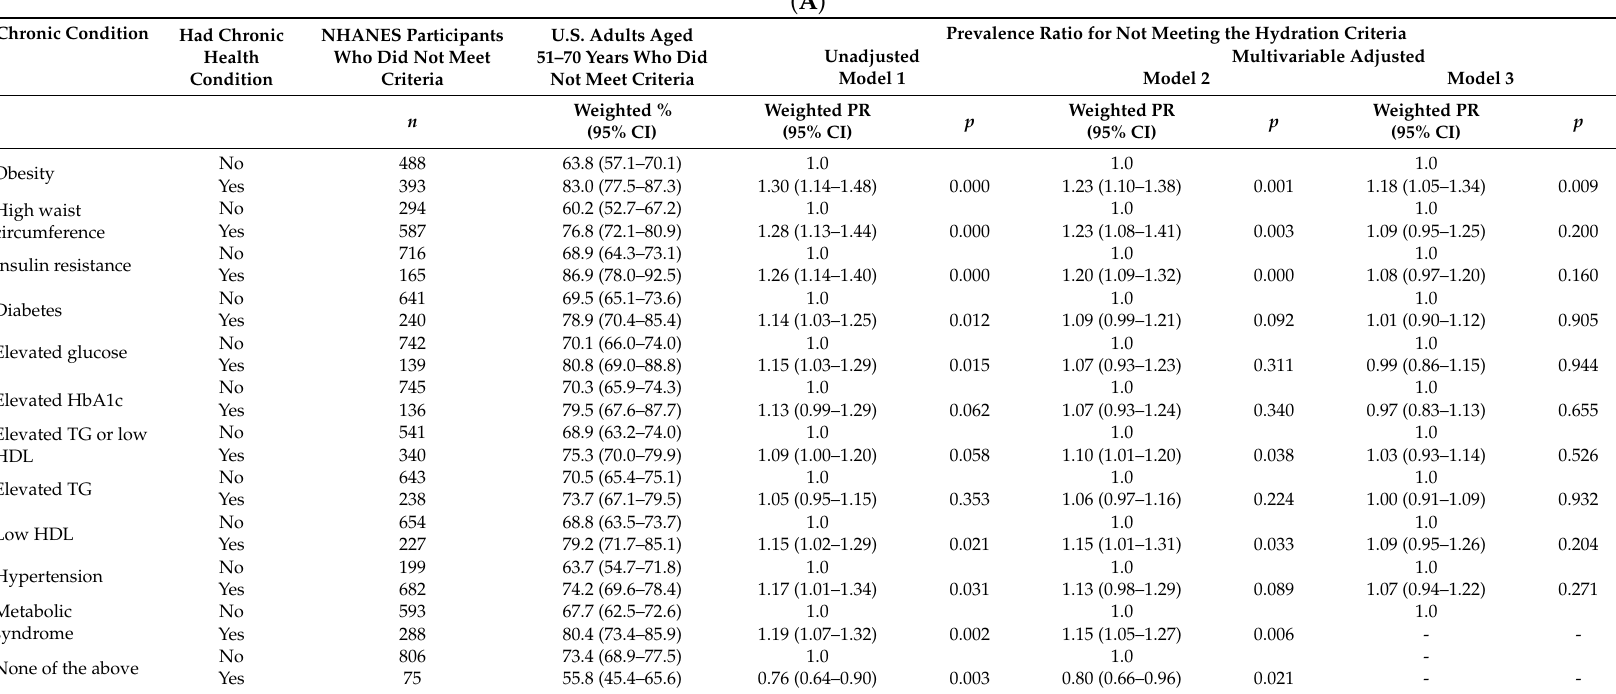
Table 2. (A) Prevalence ratio for not meeting the hydration criteria associated with chronic health conditions for fasted U.S. adults aged 51–70 years. (B) Prevalence ratio for underhydration associated with chronic health conditions for fasted U.S. adults ages 51–70